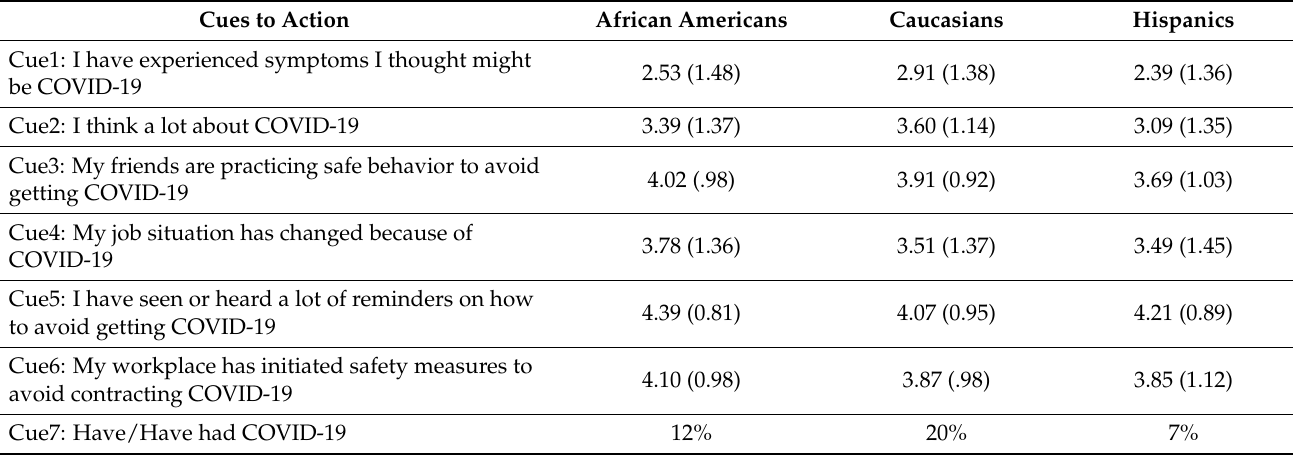
Table 5. Cues to Action across Ethnic